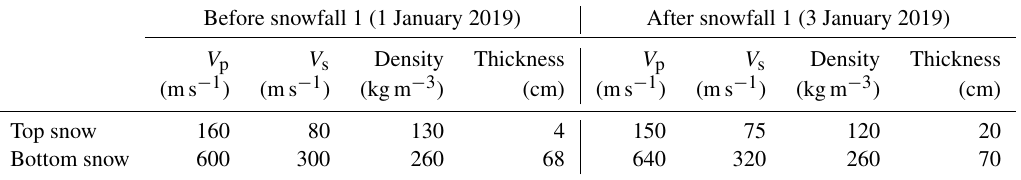
Table 3. Values of the snow model for snowfall 1 (SF1).